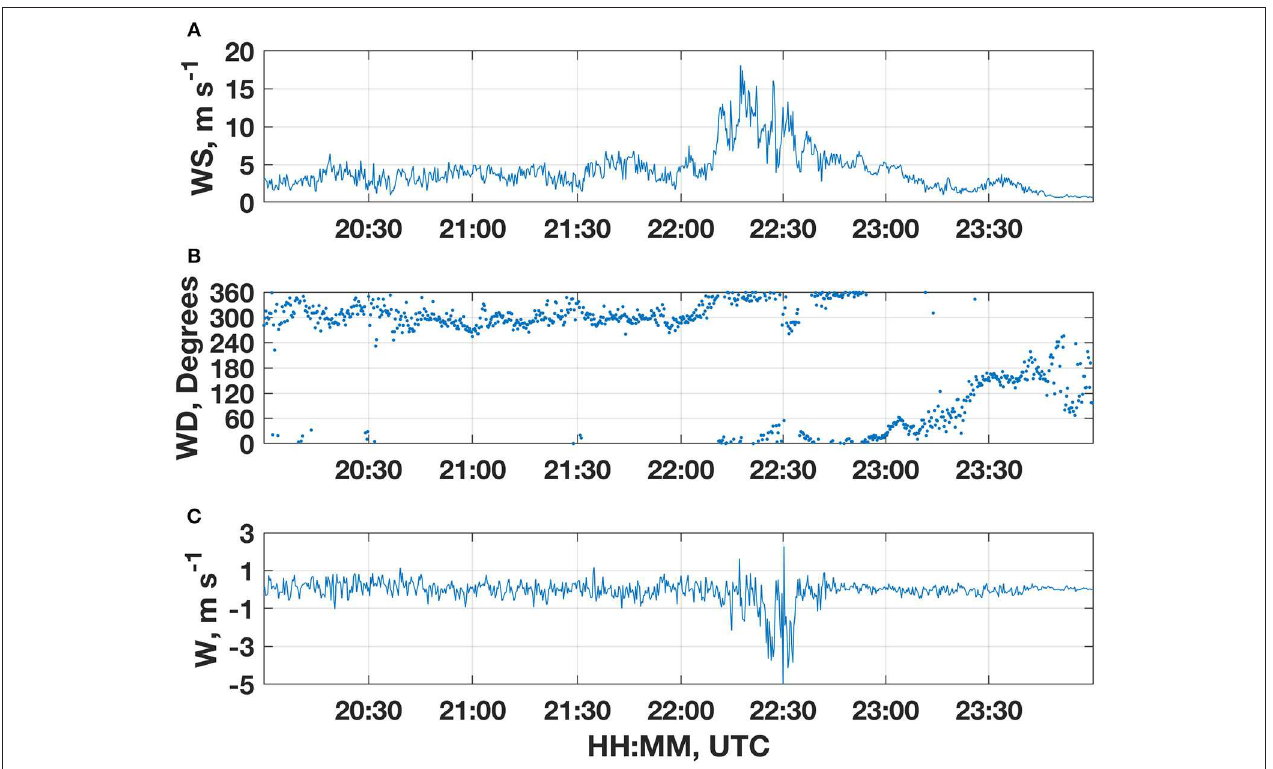
FIGURE 6 | Time series of the 29m (A) horizontal velocity (B) wind direction and (C) vertical velocity measured by the ZephIR lidar during the 23 July 2017 thunderstorm